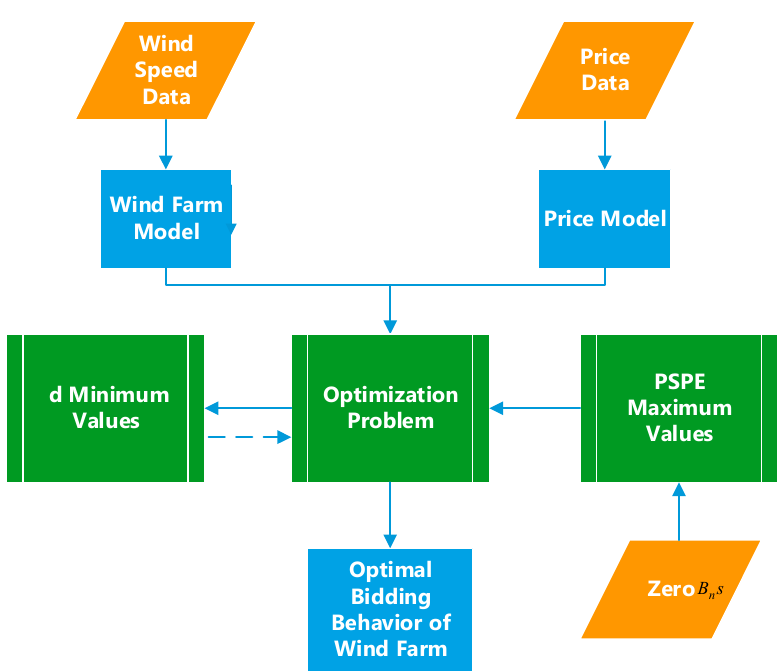
Figure 1. Steps for obtaining the expected revenue of a wind farm, considering the uncertainty of bidding admission.